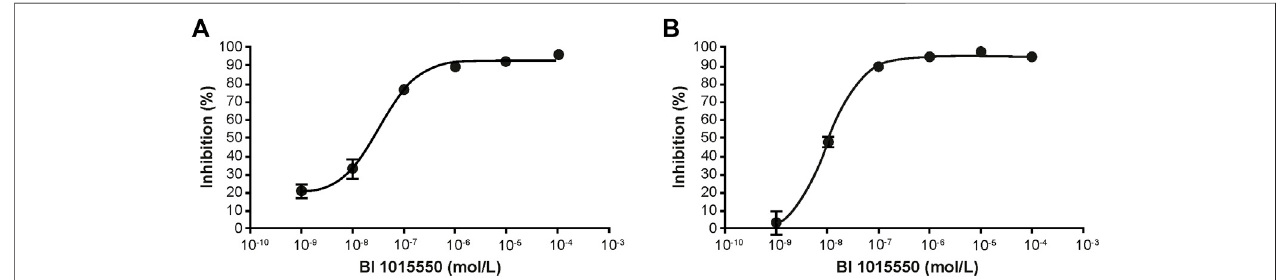
FIGURE1| InhibitionofcytokinereleaseinhumanPBMCs.TNF- α (A) andIL-2 (B) wereinducedbyLPSandPHA-P,respectively.PBMCswereincubatedat37 ° C, 5%CO 2 ,and95%humidityinthepresenceorabsenceofBI1015550andstimulatedeitherwith100 ng/mLLPSfor4 h(TNF- α assay),orwith10 µg/mLPHA-Pfor20 h (IL-2 assay). Results are given as means ± SEM from 6 different donors. IL-2, interleukin-2; LPS, lipopolysaccharide; PBMC, peripheral blood mononuclear cell; PHA-P, phytohemagglutinin-P; SEM, standard error of the mean; TNF- α , tumor necrosis factor- α .